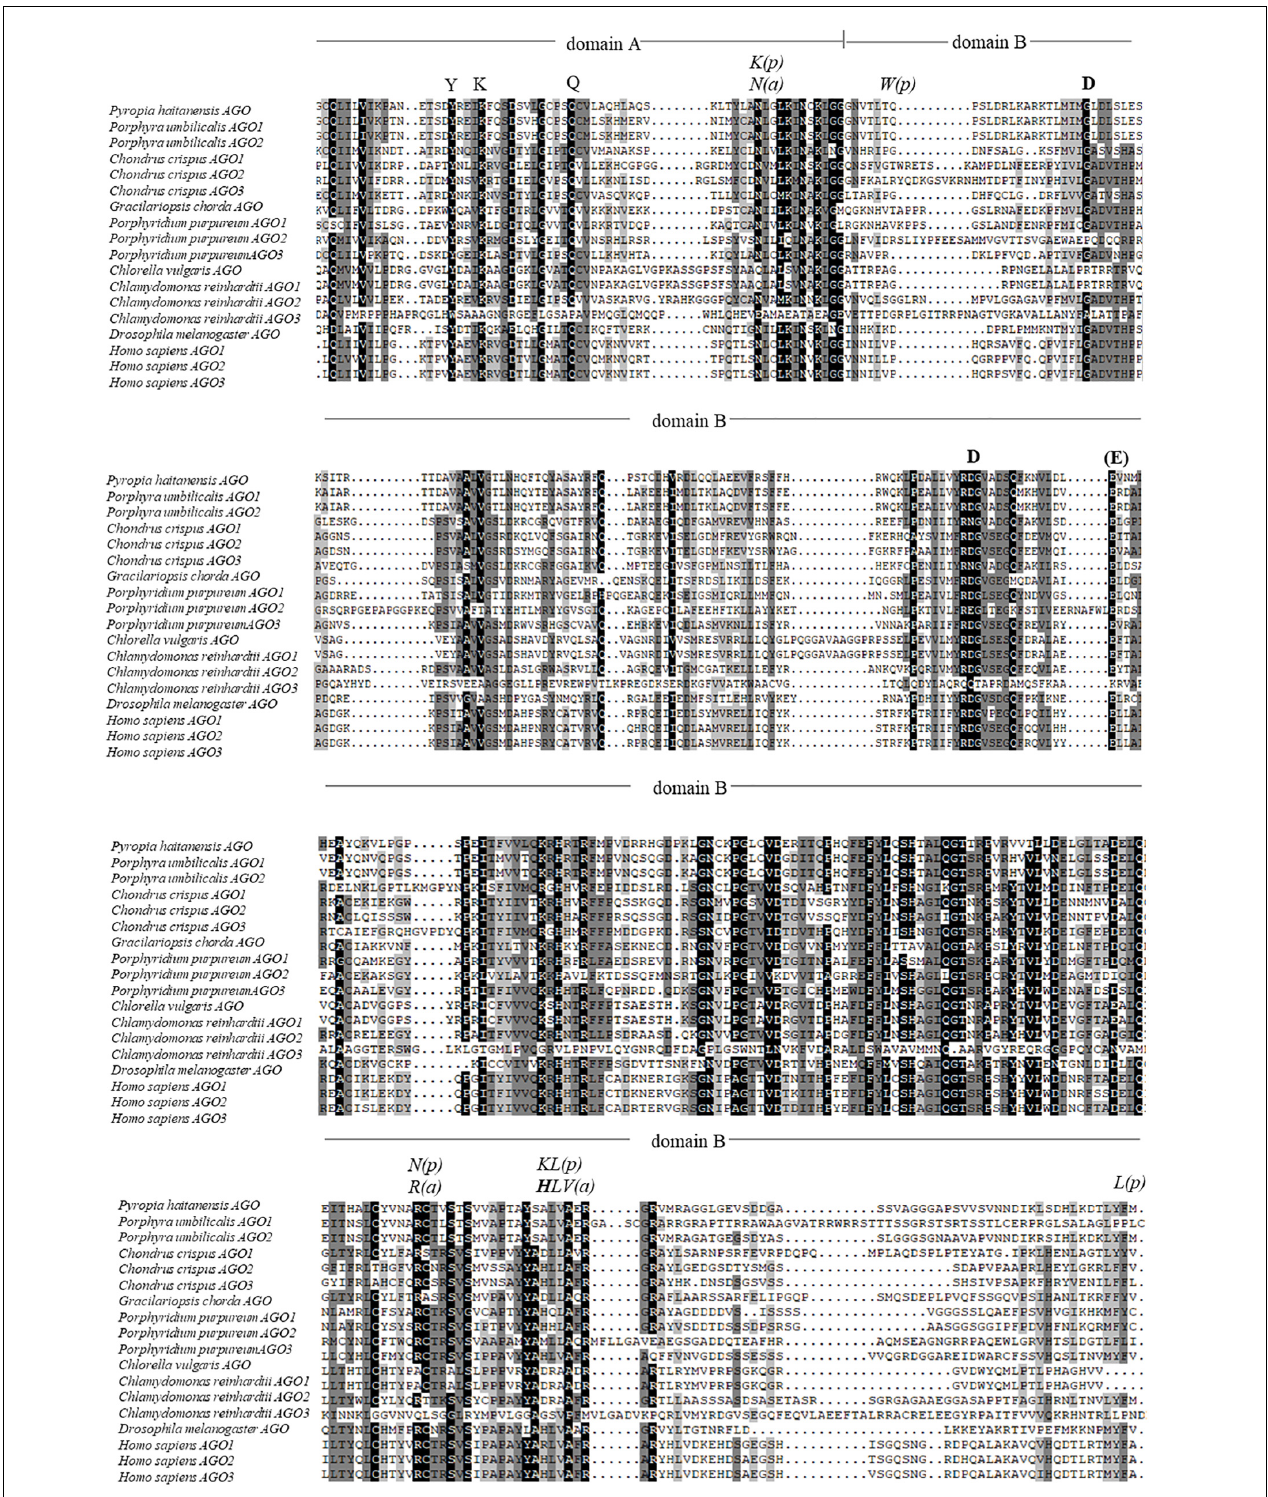
FIGURE 5 | Sequence alignment of Argonaute PIWI domains. Accession numbers of AGOs in P. haitanensis and other species were listed in Supplementary Table S4 . Residues highlighted in dark gray are shared ≥ 75% similarities, media gray are those shared ≥ 50% similarities, light gray are those shared ≥ 30% similarities in all sequences. Conserved amino acids were marked as N/Q, D/E, R/K, S/T, F/Y, A/G, and V/I/L/M in this figure. D, D and H amino acid residues in bold letters represent the DDH motif. Italicized residules are class-switch residues that attribute a given protein either to the (p)iwi or to the (a)rgonaute subfamily.